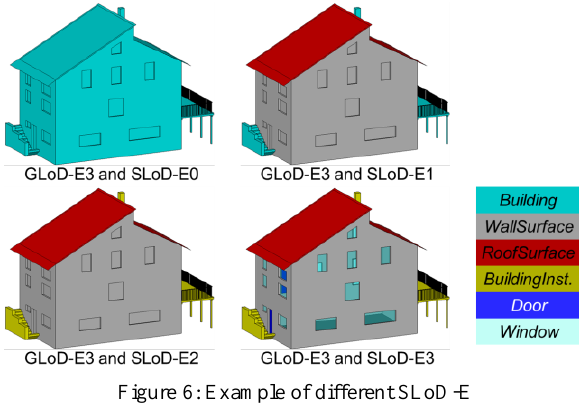
Figure 6: Example of different